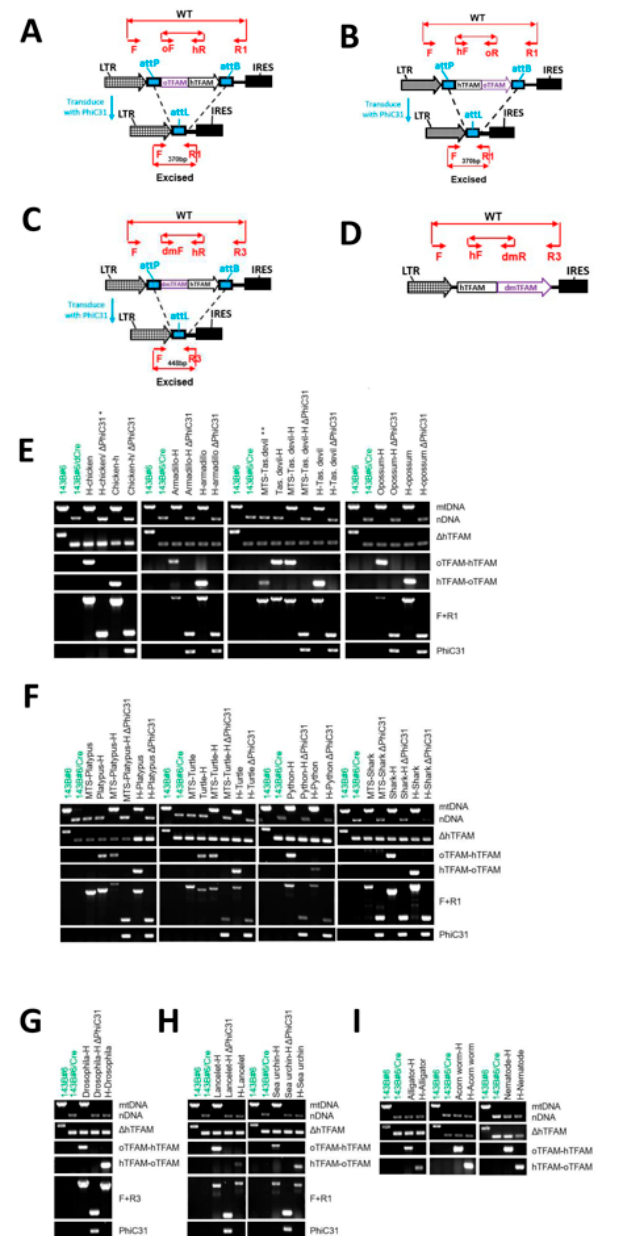
Figure 4. Screening oTFAM chimeras for their ability to support replication of hmtDNA. ( A , B ), PCR genotyping strategies for cells expressing oTFAM chimeras. ( C , D ), PCR genotyping strategies for cells expressing dmTFAM-hTFAM and hTFAM-dmTFAM chimeras, respectively. ( E , F ), PCR genotyping of oTFAM chimeras in which both NTD and CTD support hmtDNA replication ( G , H ), PCR genotyping of oTFAM chimeras in which only NTD supports hmtDNA replication ( I ), PCR genotyping of oTFAM s chimeras in which neither NTD, nor CTD supports hmtDNA replication. MTS, matrix targeting sequence of the human ornithine transcarbamylase was appended in front of oTFAM. *, excised by transiently transfecting cells with pMA4854 (Supplementary Figure S1). **, a spurious PCR product in hTFAM-oTFAM PCR due to homology between hTFAM and tdTFAM . mtDNA, nDNA, ∆ TFAM ,